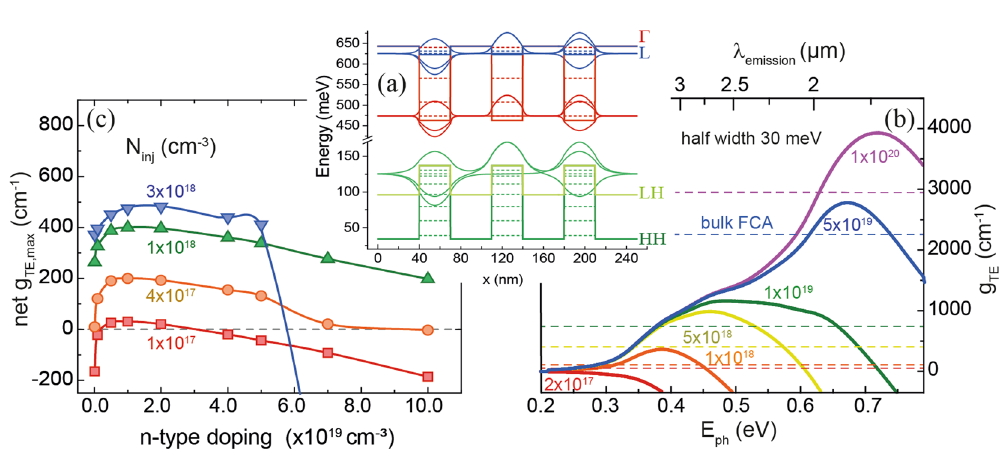
Figure 4. ( a ) Band diagram of an unstrained 3 × {30 nm Ge 0.84 Sn 0.16 /40 nm Si 0.10 Ge 0.75 Sn 0.15 } MQW. Dashed lines represent quantized energies and wavefunctions of ground states of each valley. ( b ) TE-mode material interband gain at 300 K for different injected carrier densities. Dashed lines indicate FCA values for bulk Ge 0.84 Sn 0.16 . ( c ) Net gain dependence on n-doping density, where FCA has been subtracted from interband